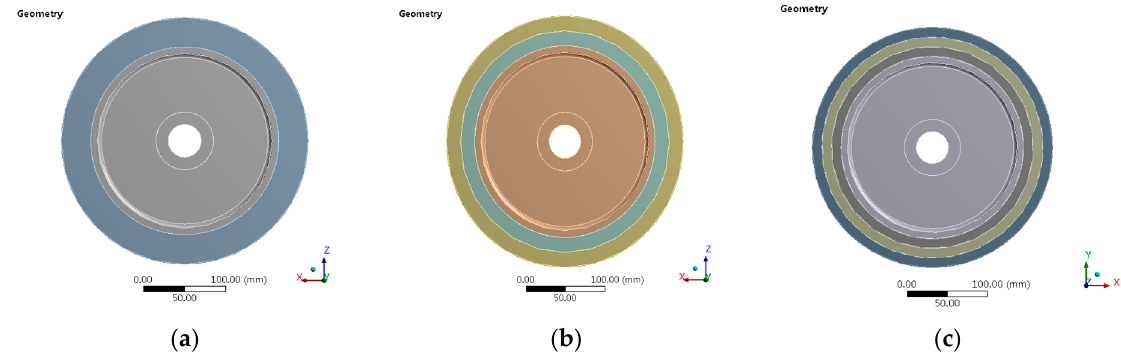
Figure 6. Three-dimensional model of flywheel rotor under different schemes. ( a ) Scheme I; ( b ) scheme II; ( c ) scheme III.